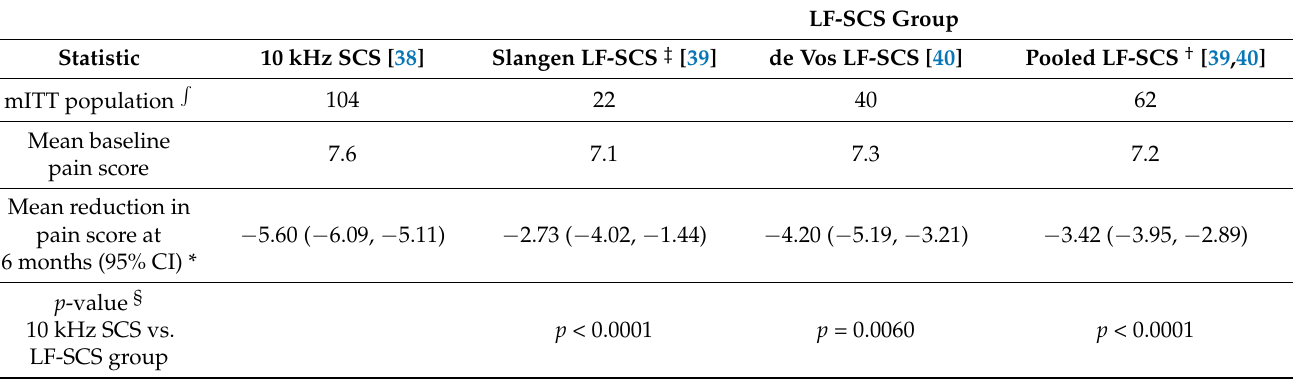
Table 2. Comparison of the mITT population mean pain intensity reductions from baseline at 6